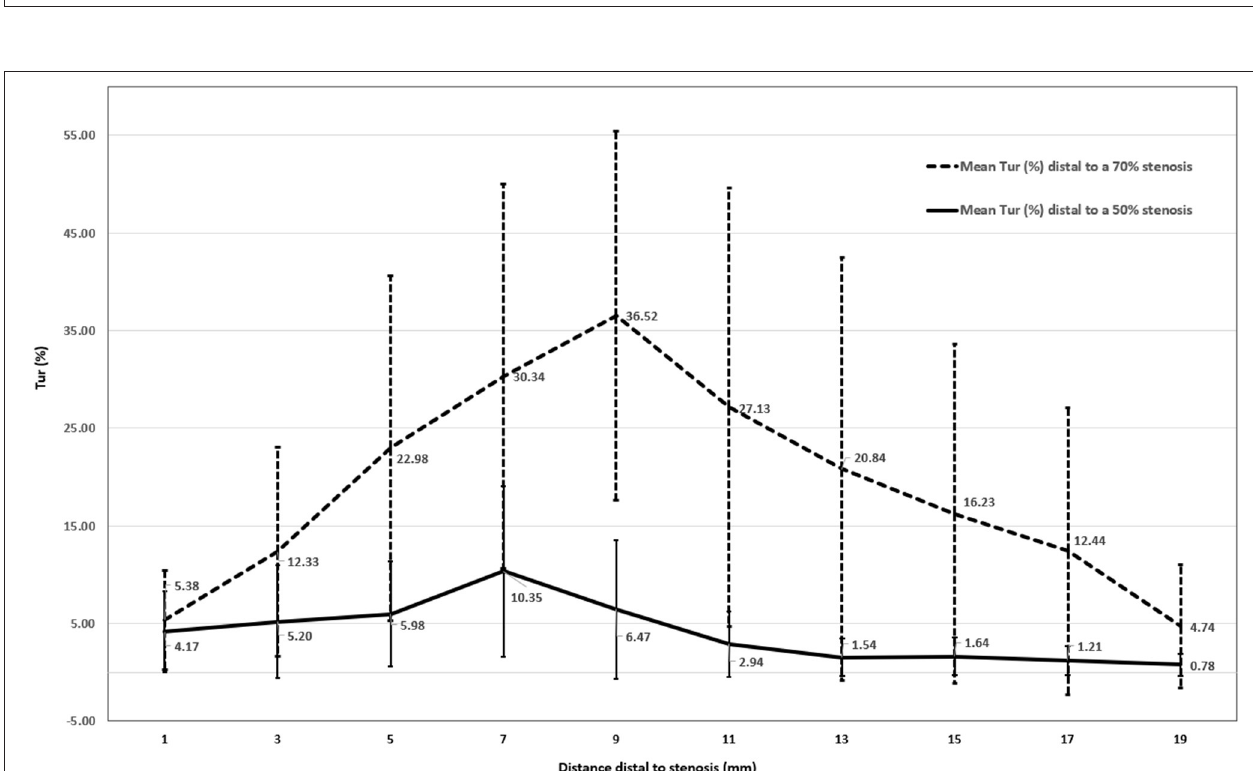
FIGURE 7 | Mean Tur index changes distal to a 50% stenosis ( N deviation of the means).